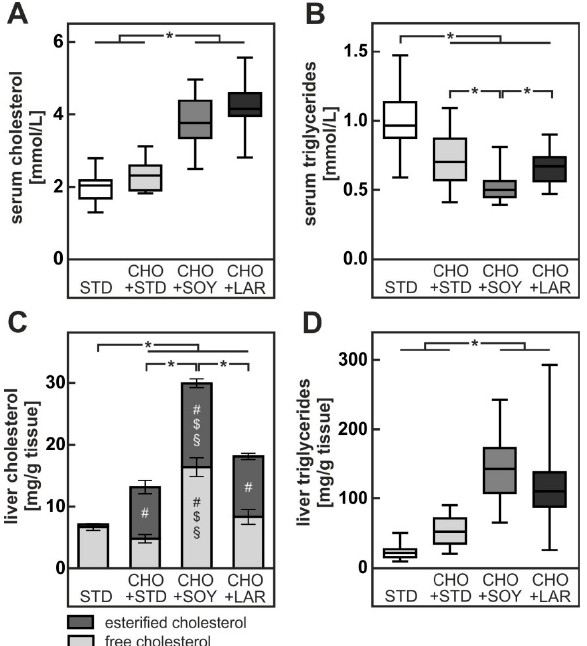
Figure 2. Diet-induced changes in serum and liver lipids after 20 weeks. ( A ) Cholesterol concentrations in serum. ( B ) Triglyceride concentrations in serum. ( C ) Levels of free and esterified cholesterol in liver. ( D ) Triglyceride levels in liver. Values are median (line), upper- and lower quartile (box) and extremes (whiskers) ( A , B , D ) or mean and sem ( C ) of 17–35 mice per group. Statistics: One-way-ANOVA with Tukey’s post hoc test for multiple comparisons. *: p < 0.05. Separate statistic for free and esterified cholesterol ( C ): #: vs. STD, $: vs. CHO + STD, §: vs. CHO+ LAD with p < 0.05.